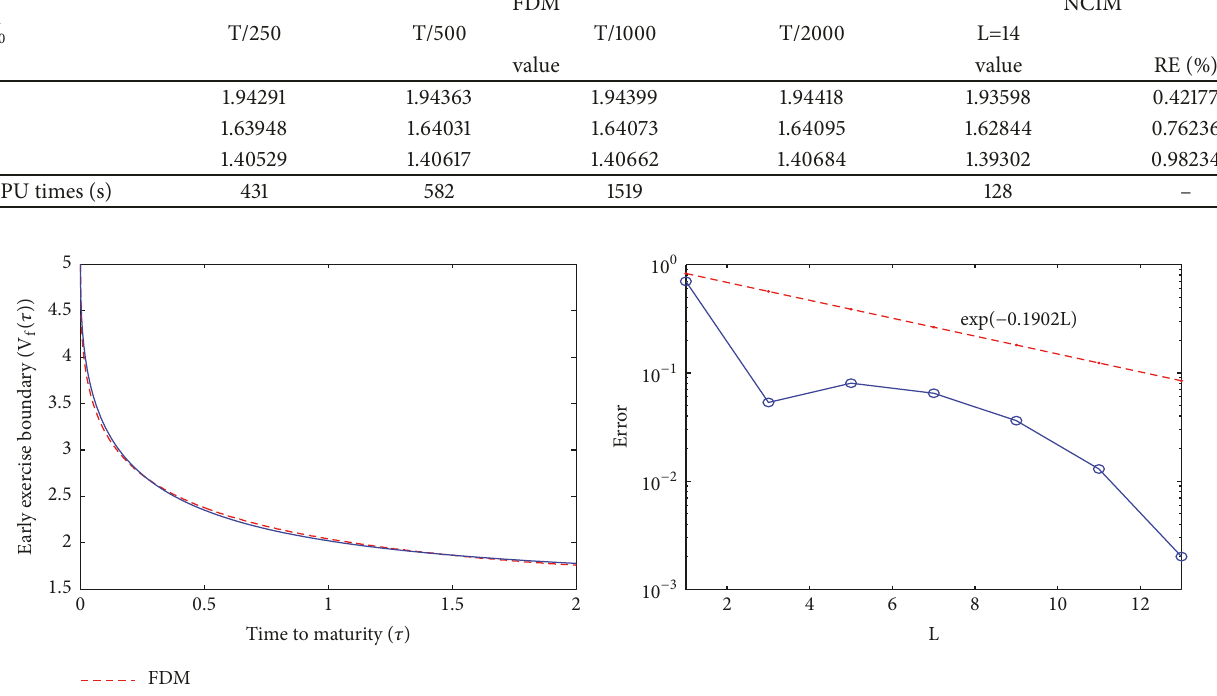
Figure 5: Early exercise boundaries (left) under MRLP model with 𝑇/2000 for FDM and 𝐿 = 14 for NCIM, NCIM errors in log-scale versus 𝐿